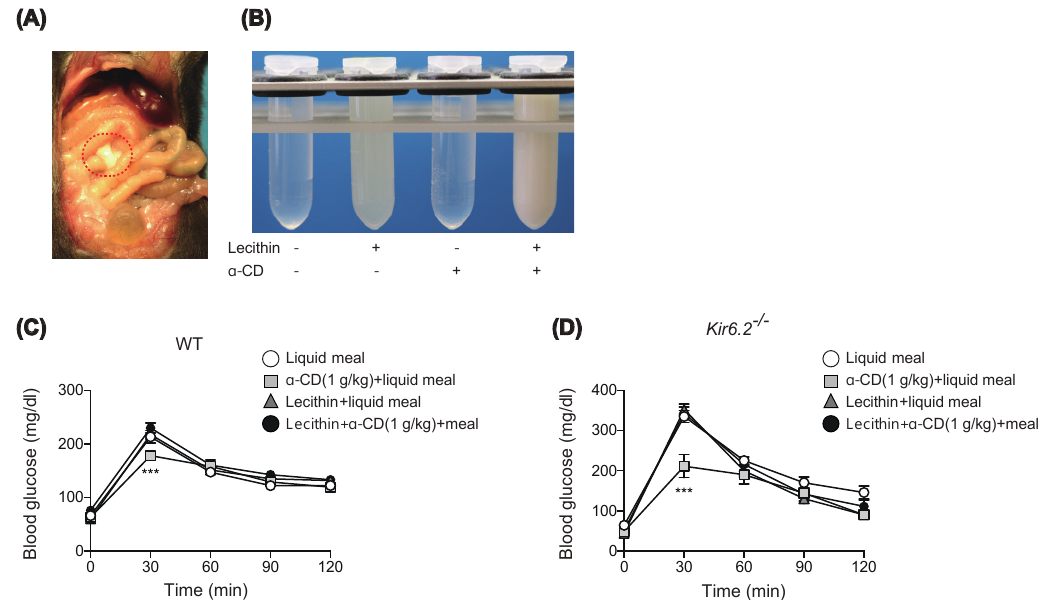
Figure 4. Effect of preinclusion of 1 g/kg α‐ CD with lecithin during MTT. ( A ) Appearance of small intestinal content (circled by a red, dotted line) at 30 min after α‐ CD administration. A small incision was made in the small intestine to induce the outflow the intestinal fluid. ( B ) Macroscopic appearance of test samples. Mixing α‐ CD and lecithin induced liquid clouding, resembling that observed in vivo ( A ). ( C , D ) Effect of preinclusion of α‐ CD with lecithin during MTT in WT ( C ) ( n = 9) and Kir6.2 − / − mice ( D ) ( n = 5). Bars depict mean ± SEM. *** p < 0.001 by unpaired ‐ Student t ‐ test.